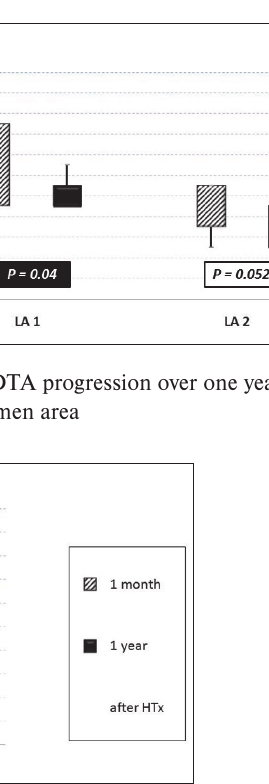
Fig. 3. MIT progression < 0.5 mm in one year (n=27) in group A and B MIT = maximal intimal thickness